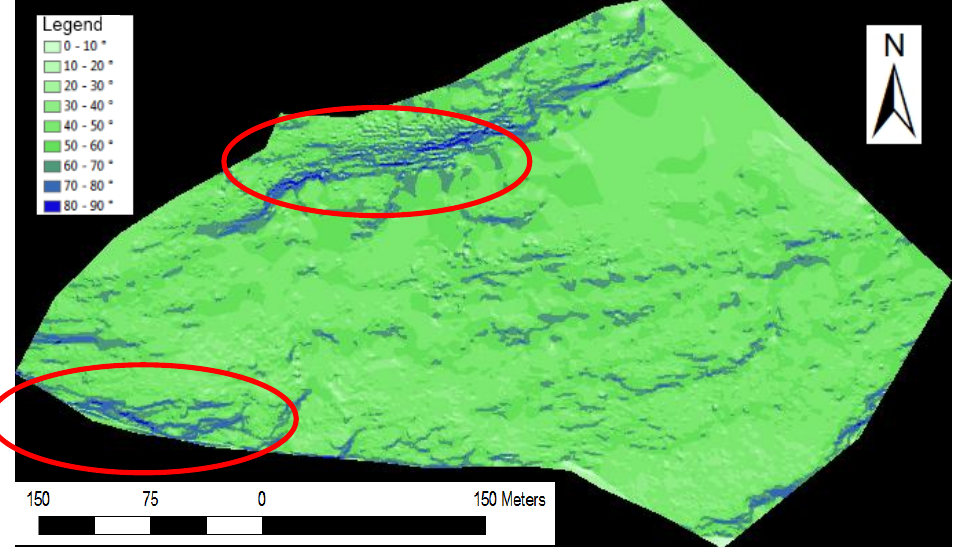
Figure 6. Inclination map of the test area, generated with the “slope” function of